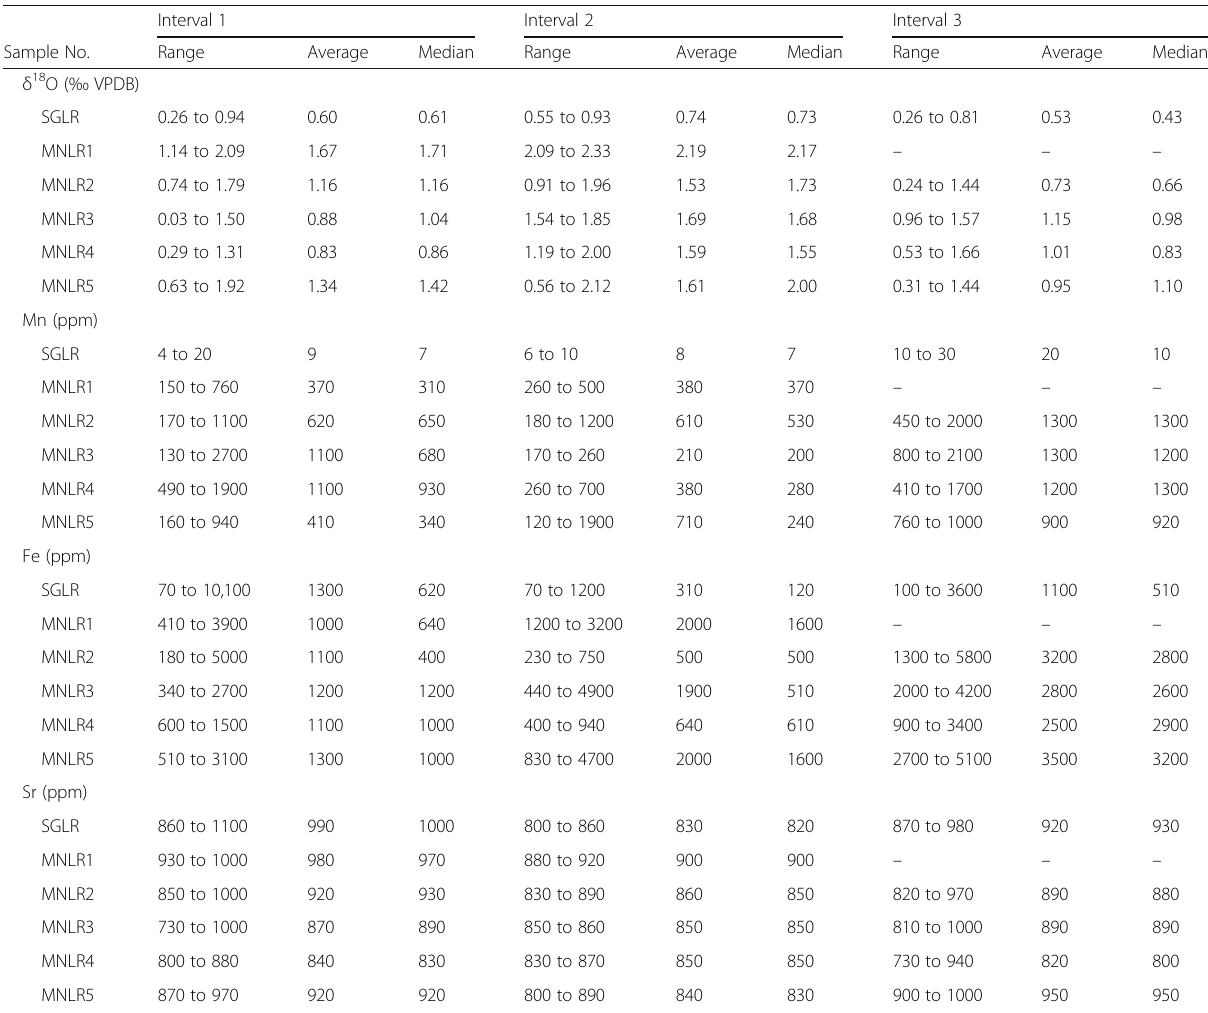
Table 1 Modern and fossil Terebratalia coreanica and Laqueus rubellus δ 13 C and δ 18 O values and minor-element concentrations